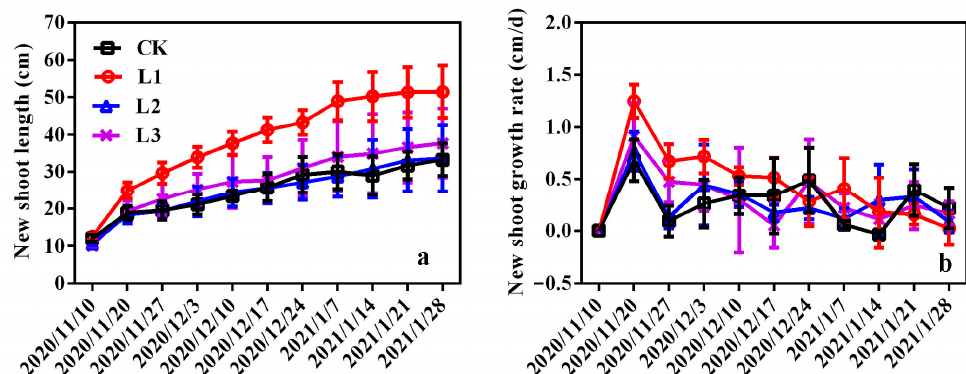
Figure 8. Dynamic changes of the new shoot length ( a ) and growth rate ( b ) of ‘Misty’ grown under different light qualities in a plant factory with artificial lighting. Note: CK, white LED light; L1, red spectrum, L2, blue spectrum, L3, 60% red + 40% blue spectrum; the bar indicates the standard deviation.